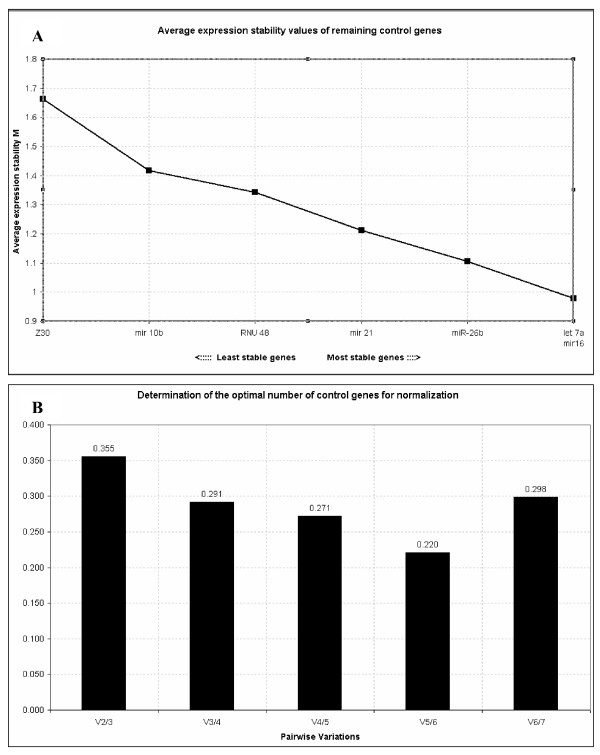
GeNorm analysis of candidate ECs. (A) Average expression stability of the EC candidates as calculated using GeNorm. A stability value (M) was calculated for each candidate EC. The least stable gene with the highest M value was automatically excluded and M values recalculated for the remaining ECs, ultimately resulting in a stability value for the two most stable ECs. (B) Determination of the optimal number of ECs for normalisation. The V value defines the pairwise variation between two sequential normalisation factors. GeNorm indicated optimal normalisation of gene expression could be achieved using the top five most stable ECs.